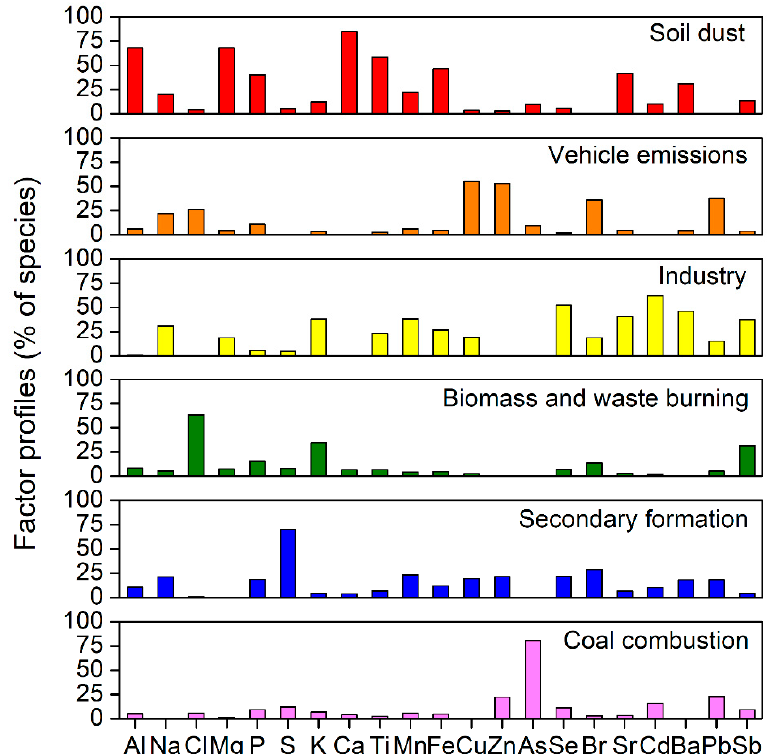
Figure 5. Source profiles of trace elements in PM 2.5 obtained through positive matrix factorization (PMF) analysis.